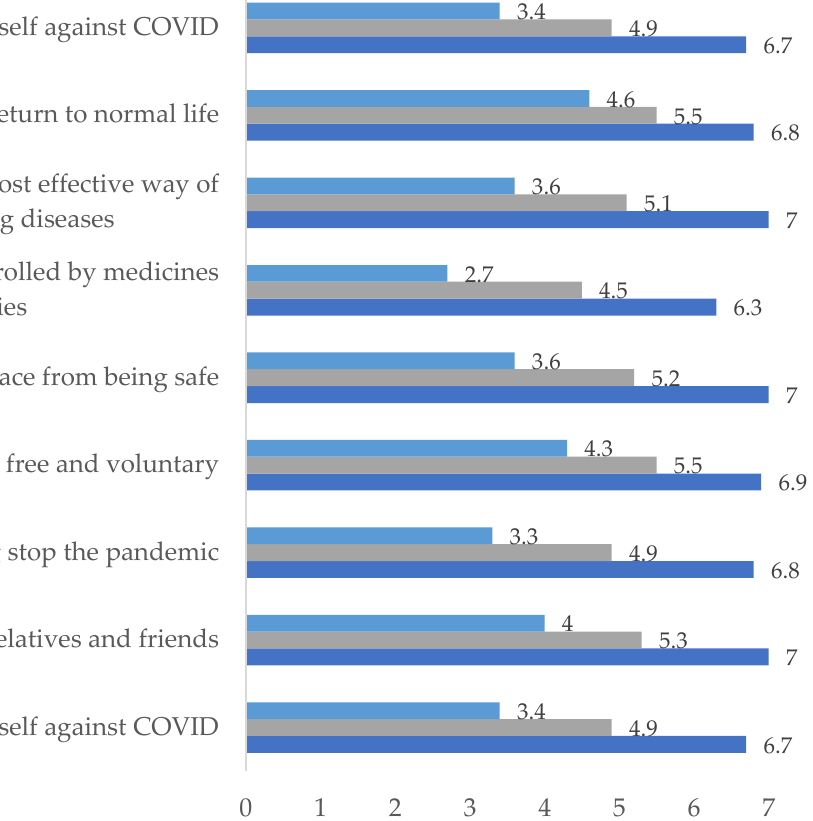
Figure 3. Reasons to get vaccinated against COVID-19 between previously anti-vaccine, undecided and pro-vaccine individuals who got vaccinated.